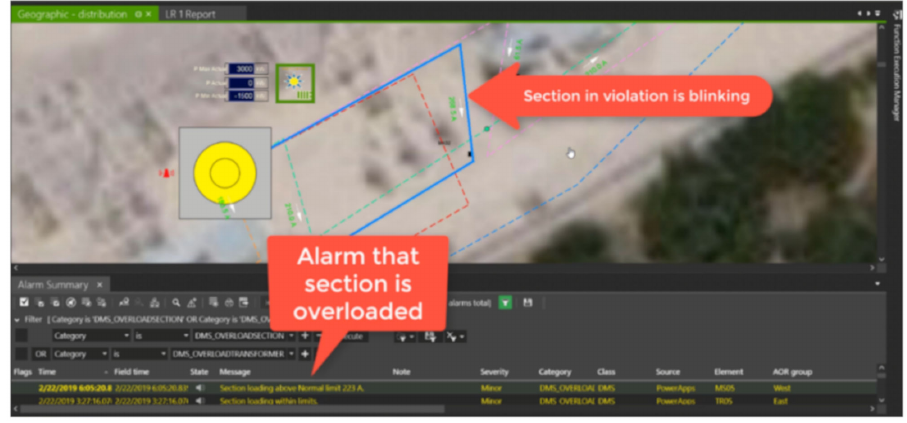
Figure 4. Overload detected through the utility DERMS.